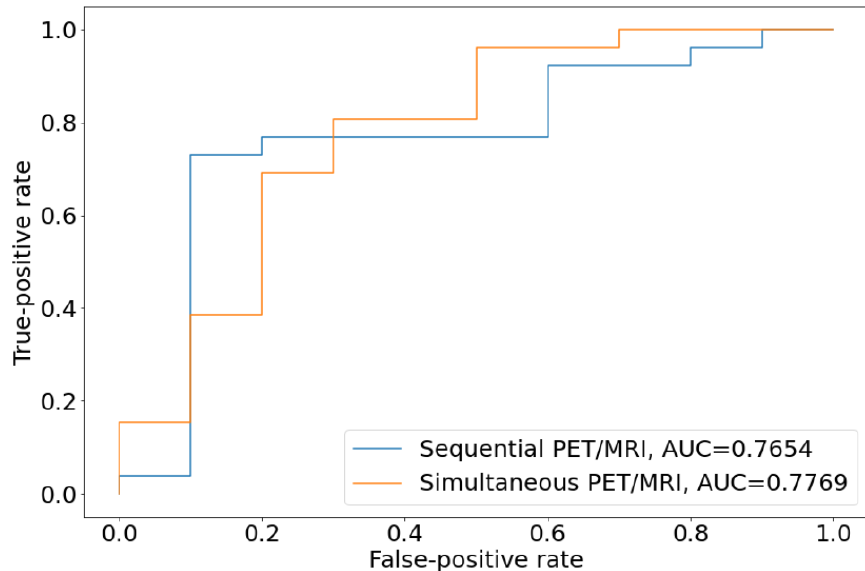
Figure 3. Receiver operating characteristics (ROC) curve analysis showed similar AUCs for the differentiation of PD and TRC. The orange line represents the ROC curve for simultaneous PET/MRI, the blue line represents the ROC curve for sequential PET/MRI ( p = 0.83, DeLong’s test.).